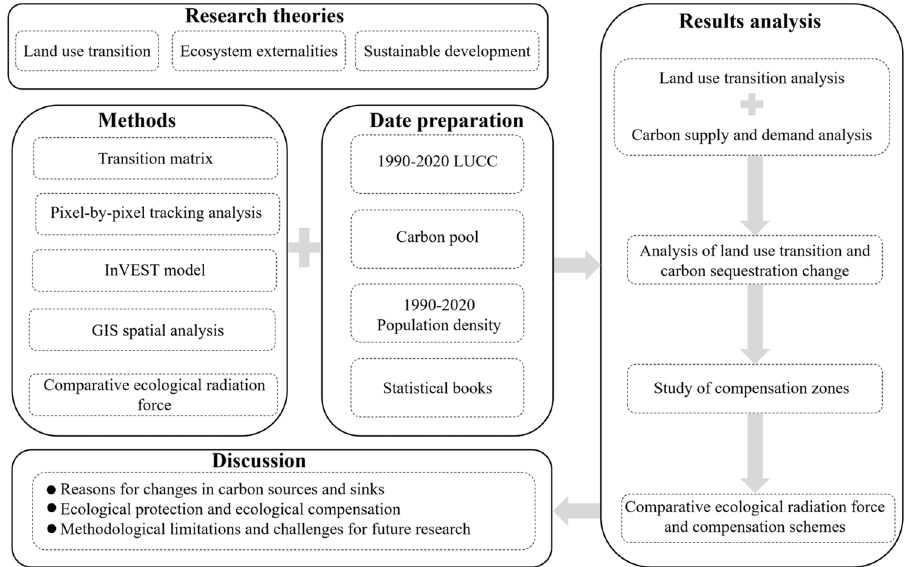
Figure 1. Research framework of this study. Software: PowerPoint 2021. URL: https:// www. micro soft. com/ zh- cn/.